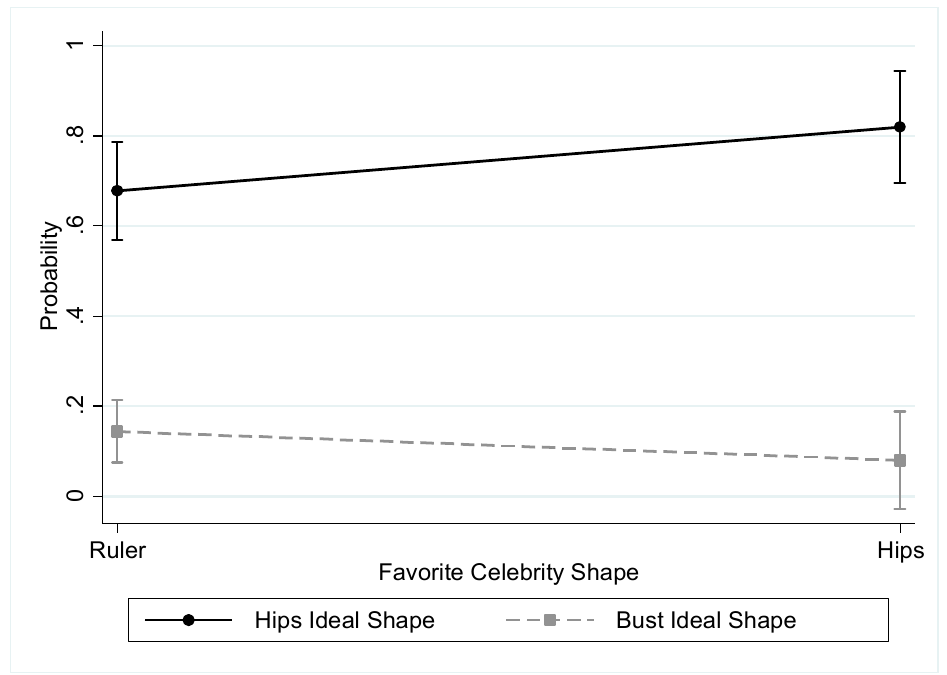
Figure 3. Predictive Margins for Thin models Treatment and Favorite Celebrity Body Shape (Hips versus Ruler).